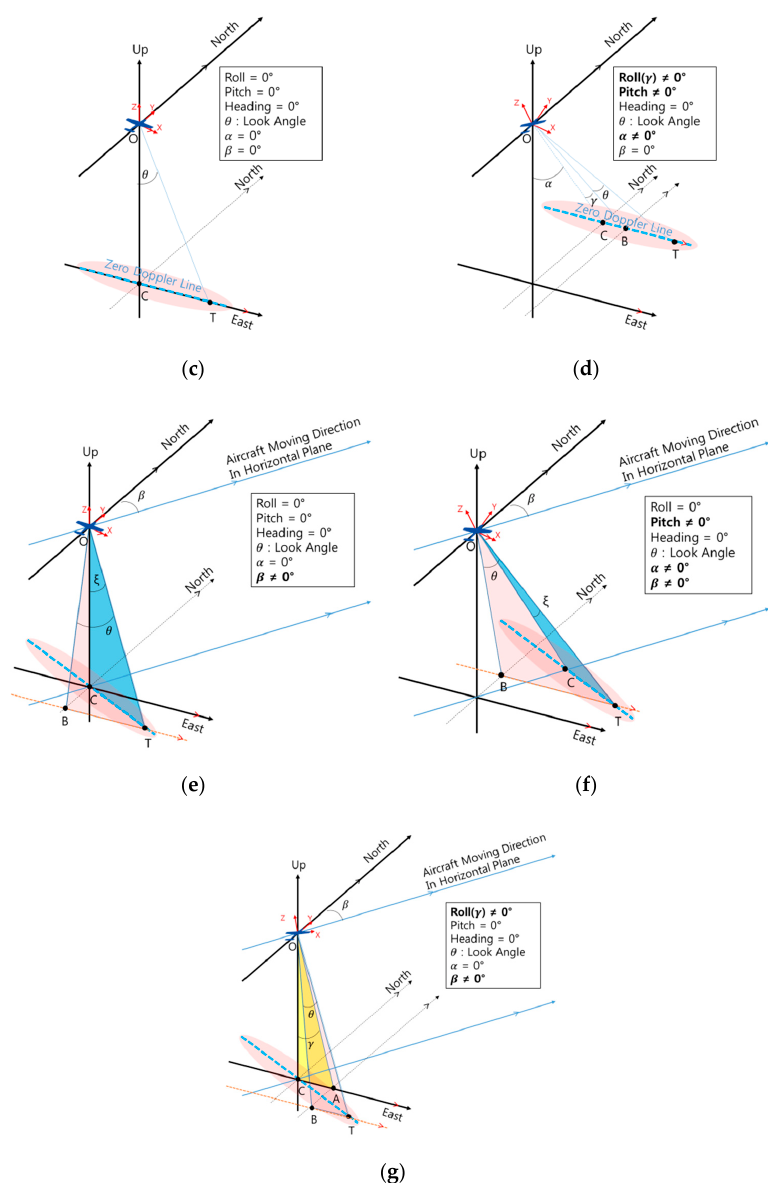
Figure 12. 3-dimensional graph of relative position from aircraft to closest point in real flight condition: ( a ) case in which roll, pitch, heading, α , and β angles are all zero; ( b ) pitch and α angles are not zero; ( c ) roll angle is not zero; ( d ) roll, pitch and α angles are not zero; ( e ) β angle is not zero; ( f ) pitch, α and β angles are not zero; ( g ) roll and β angles are not zero;